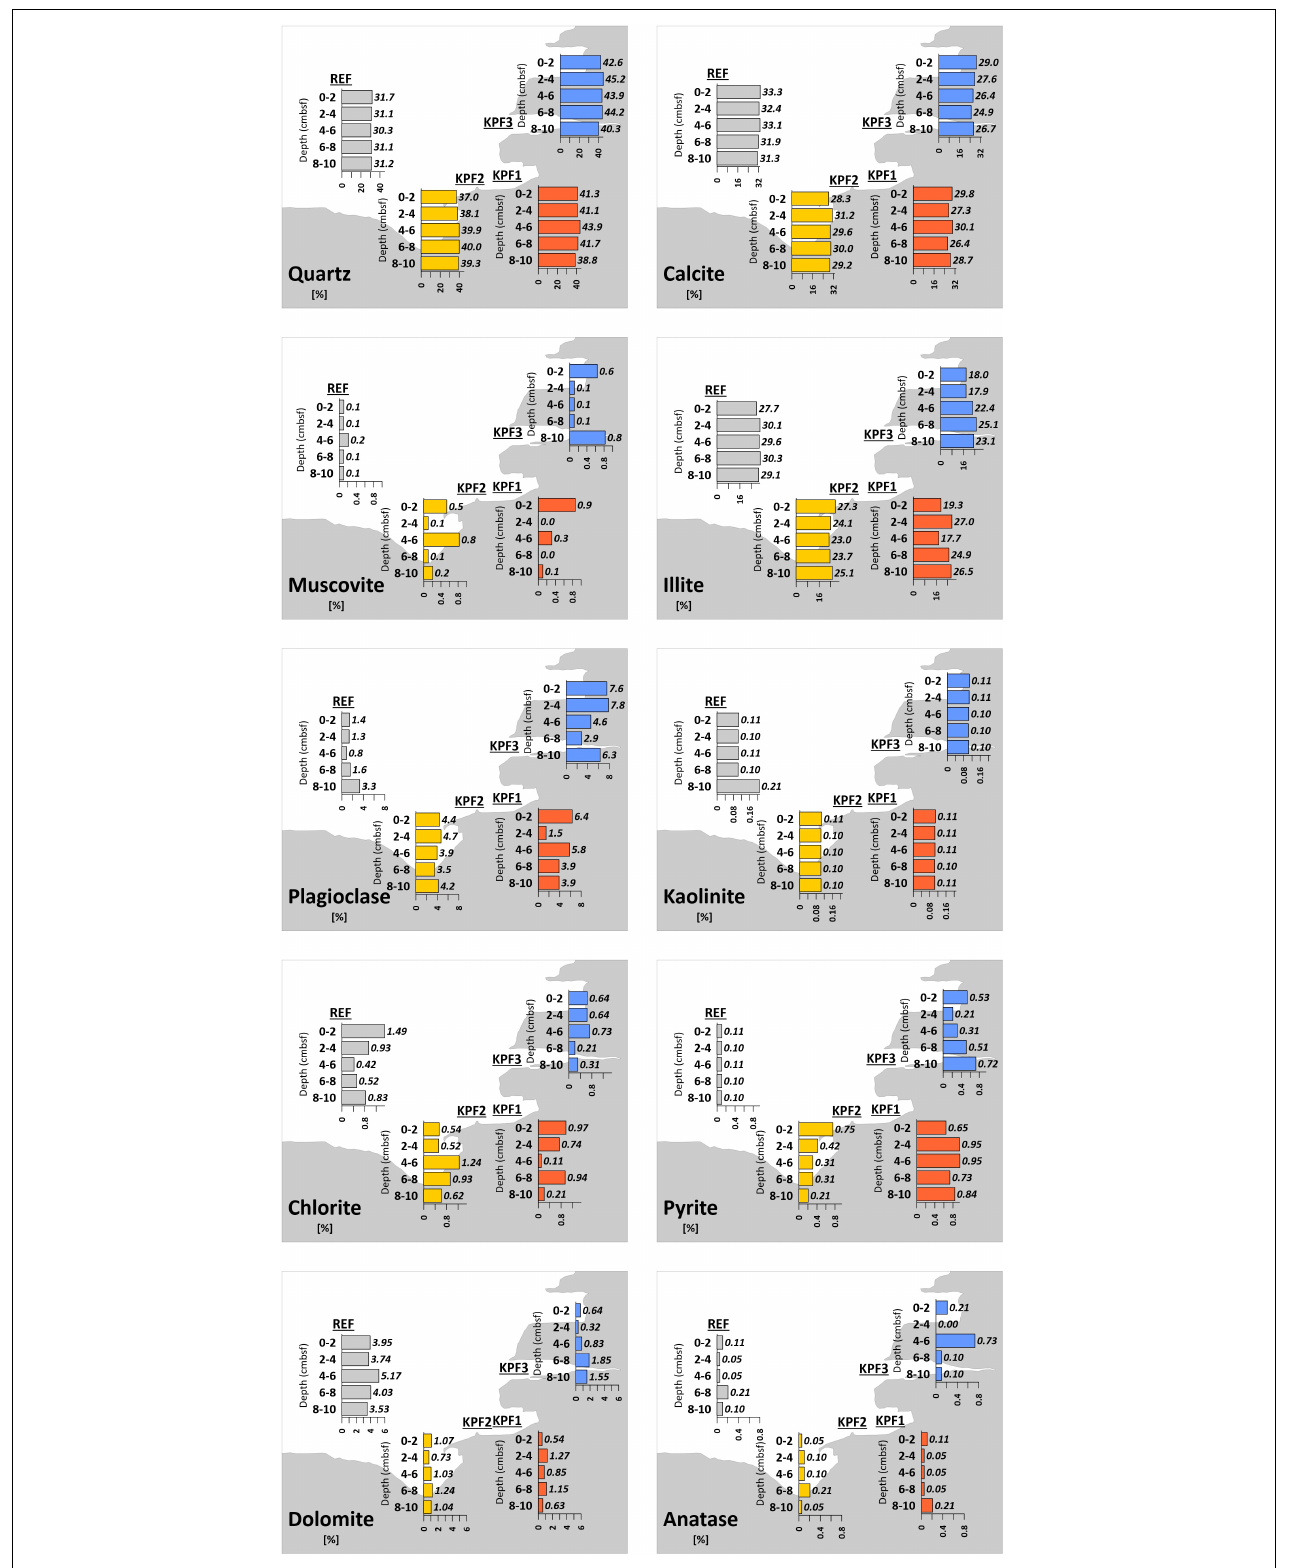
FIGURE 2 | Mineralogical composition (in%) of sediments of Bay of